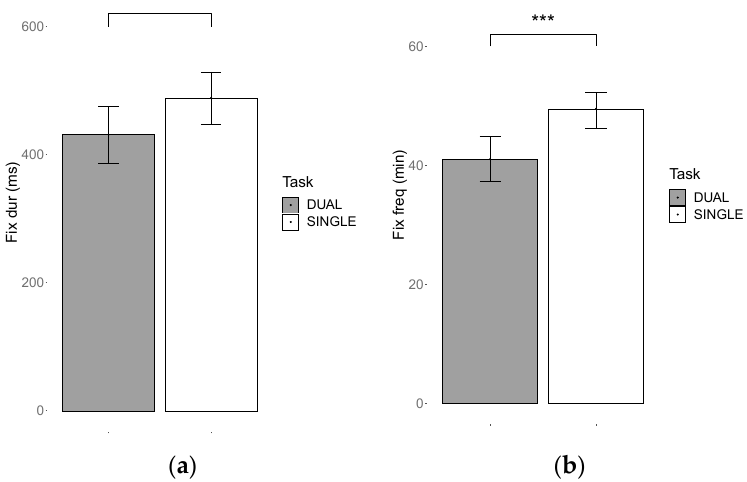
Figure 6. ( a ) Mean fixation duration and ( b ) frequency as a function of task difficulty. *** p < 0.001.